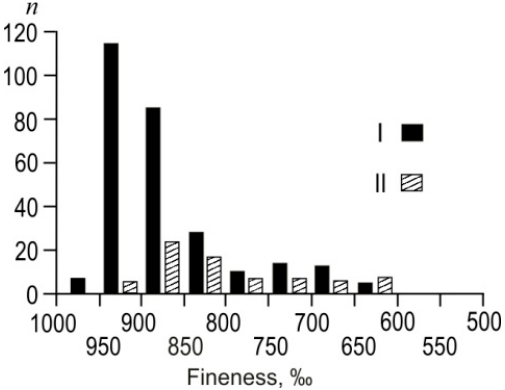
Figure 8. Frequency of native Au fineness of I and II ore substages of the Ulug-Sair ore occurrence.